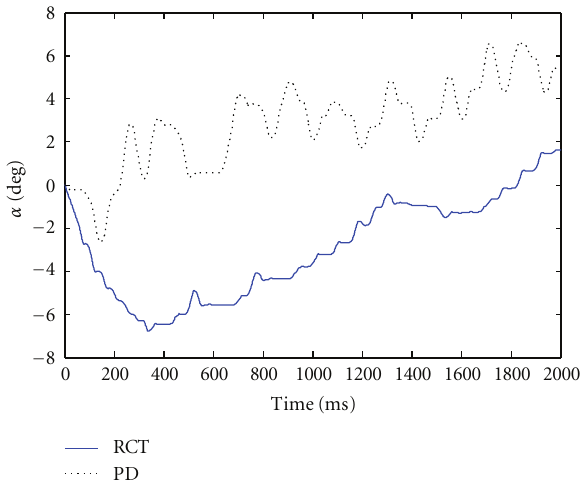
Figure 20: Heading angles of PD (black dotted line) and RCT control (blue solid line).